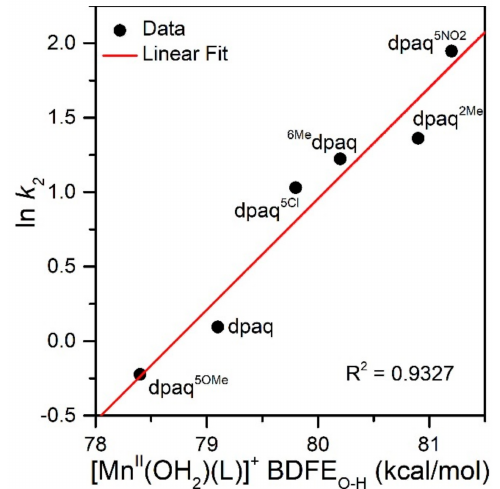
Figure 7. A plot of ln k 2 vs. Mn II -aqua O − H BDFE (kcal/mol).